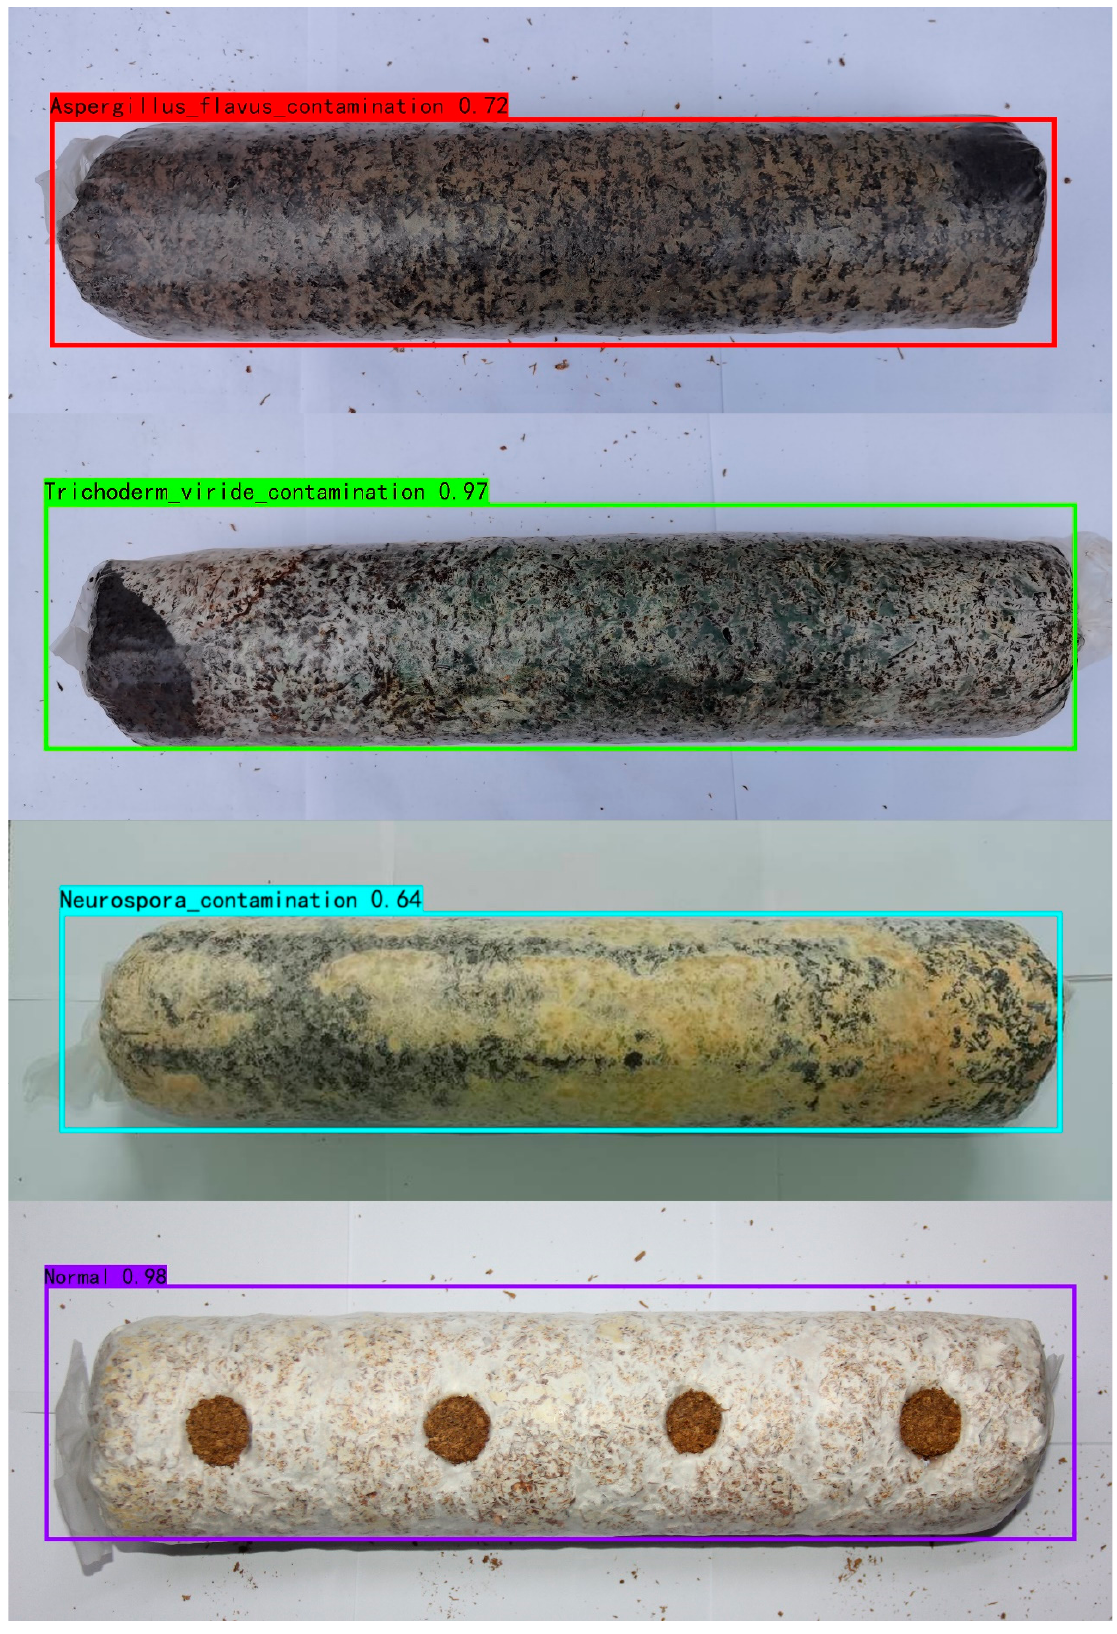
Figure 9. Target detection results of sundry bacteria contamination of Lentinula edodes logs.